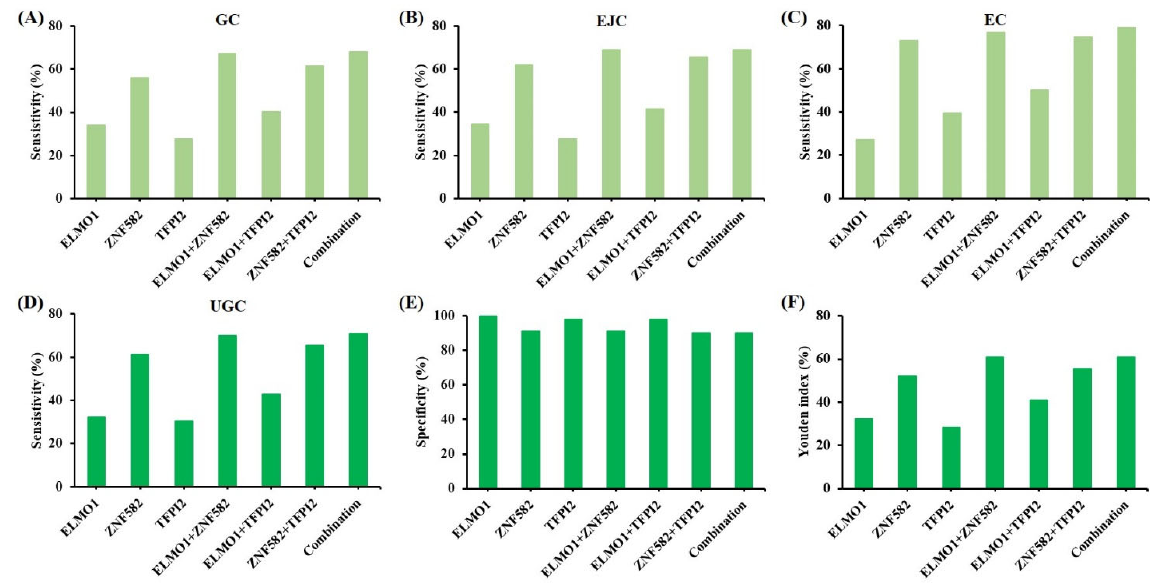
Figure 3. The sensitivities ( A – D ), specificity ( E ) and Youden index ( F ) of methylation panel in different samples.